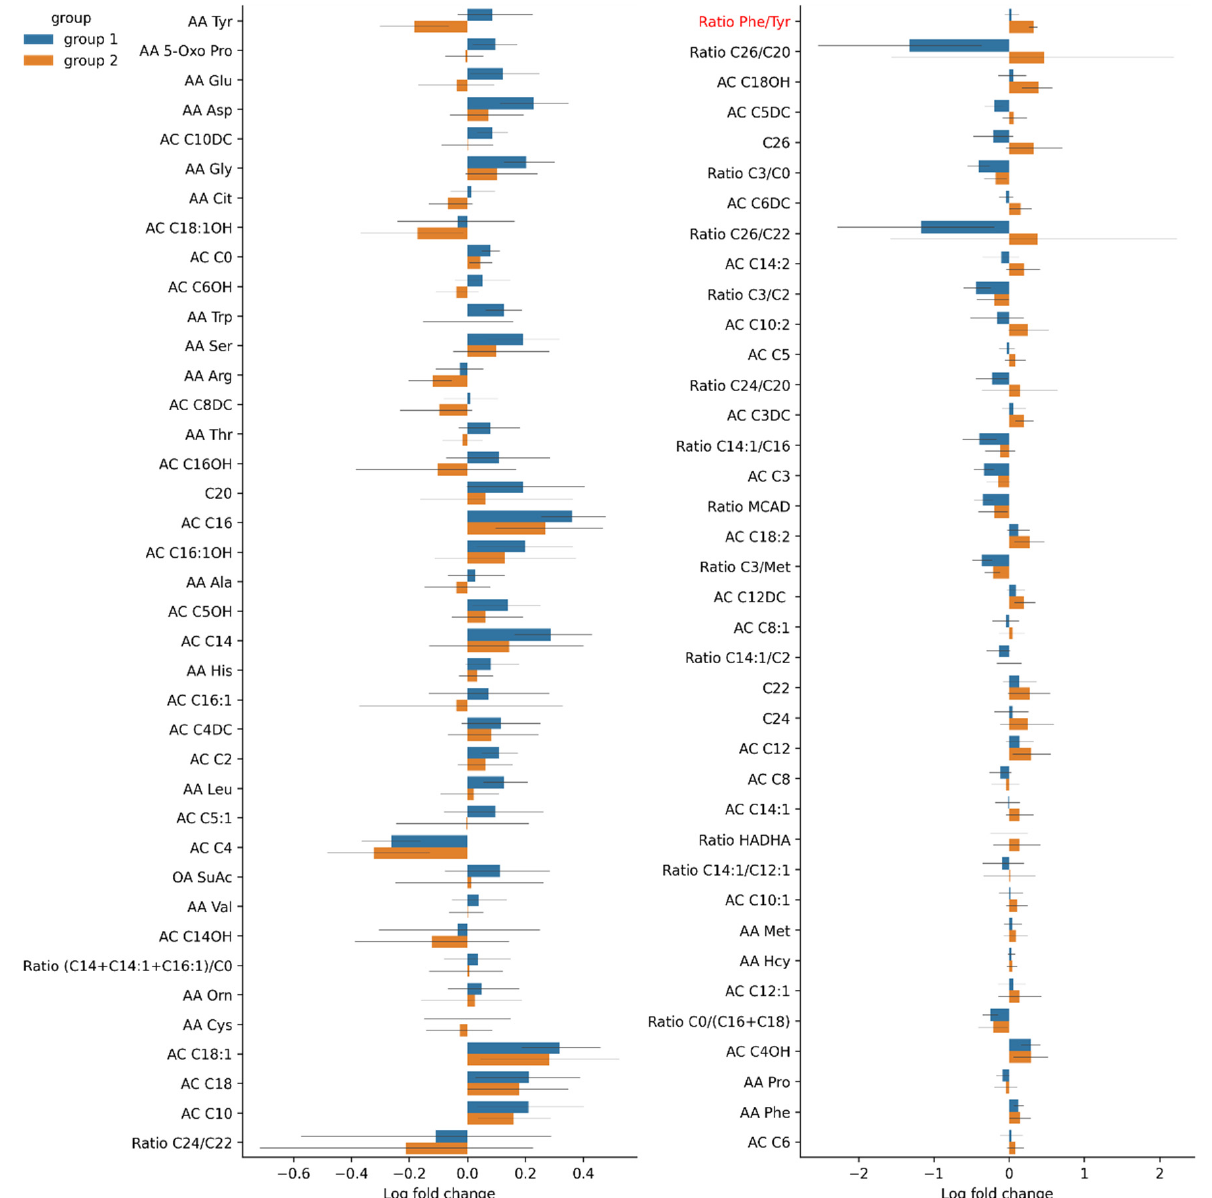
Figure 14. Fold changes in post-TBI amino acid levels in Groups 1 and 2 between days 3 and 7. Significant results are presented in red.